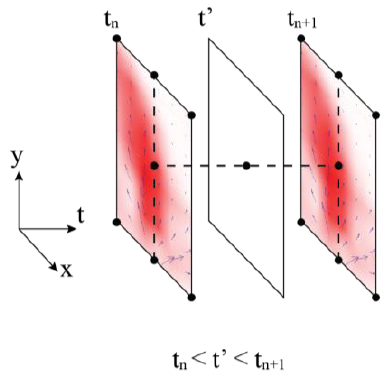
Figure 9. Visualization of linear interpolation between data streams.